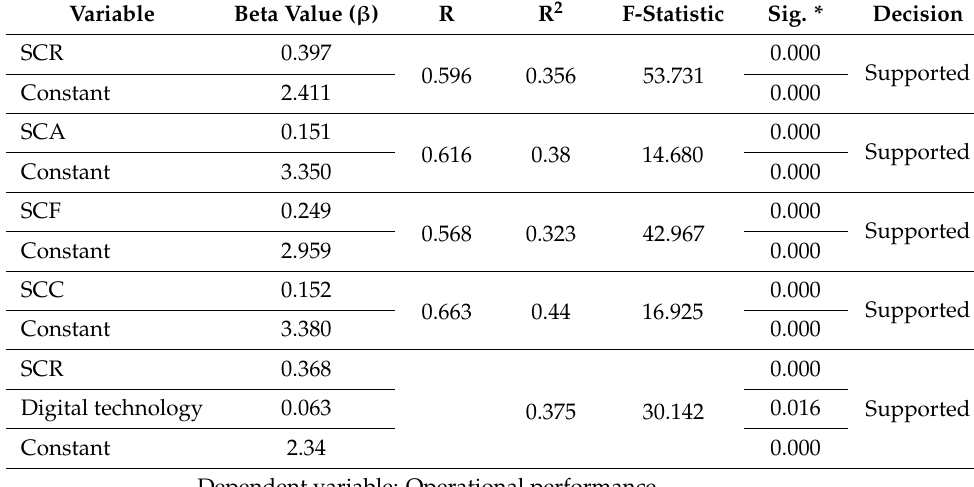
Table 10. Simple regression